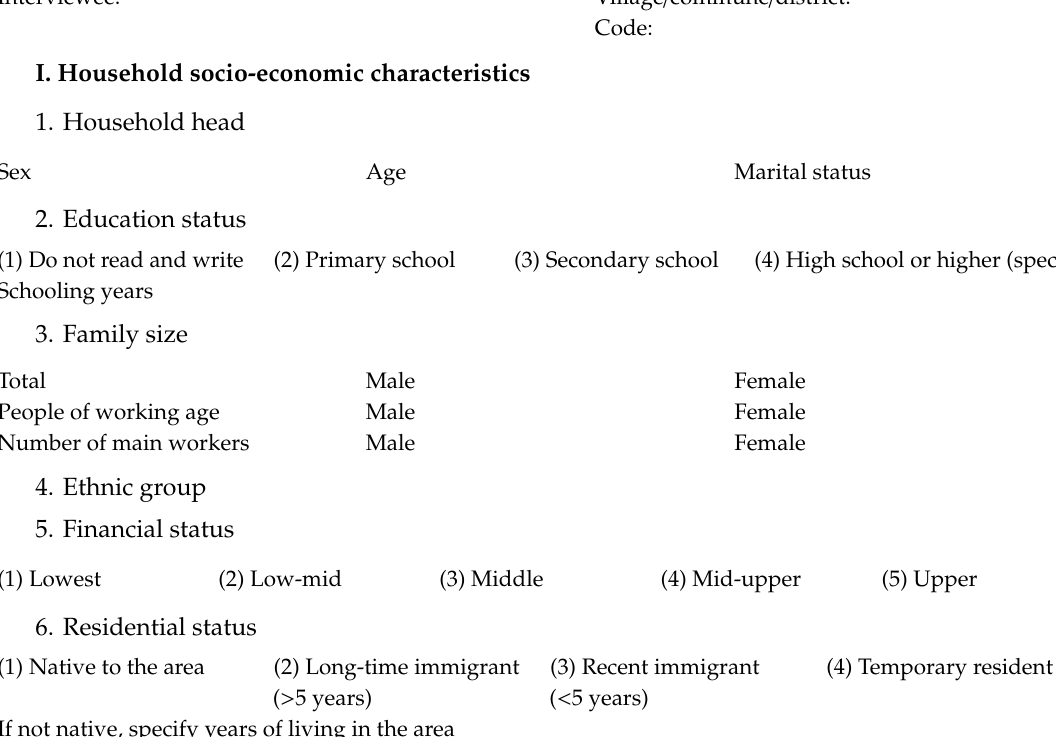
Figure S1: Productivity / ha by income groups in Nam Dong and Phu Loc district, Table S1: Study communes and their relative locations, Table S2: Socio-economic and contextual attributes used in regression model to identify Acacia hybrid timber income determinants, Table S3: Producers’ Acacia hybrid plantation land use certificates in Nam Dong and Phu Loc districts, Table S4: Acacia hybrid plantation areas owned by producers in Nam Dong and Phu Loc districts, Table S5: Best five models of Acacia hybrid timber income determinants in Nam Dong and Phu Loc district selected by BMA